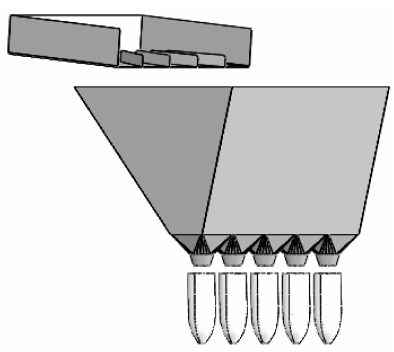
Figure 2. Model simplification of vibrating rice-filling